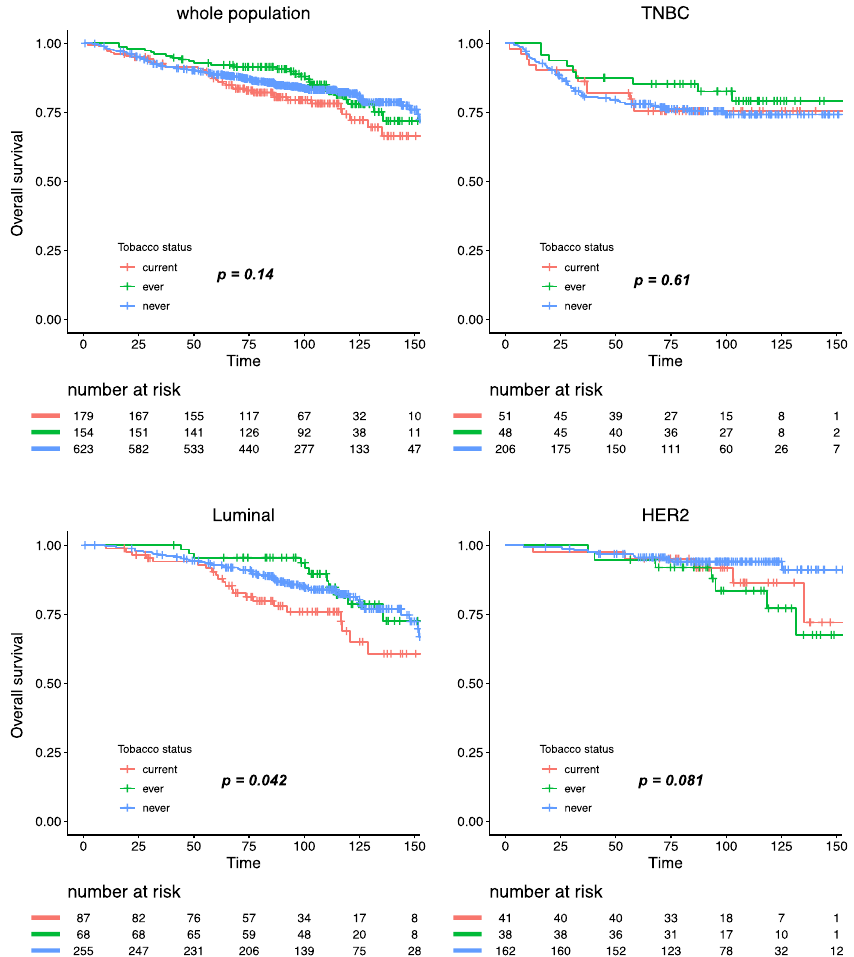
Figure 4. Relapse-free survival according to smoking status in the whole population and by BC subtype.